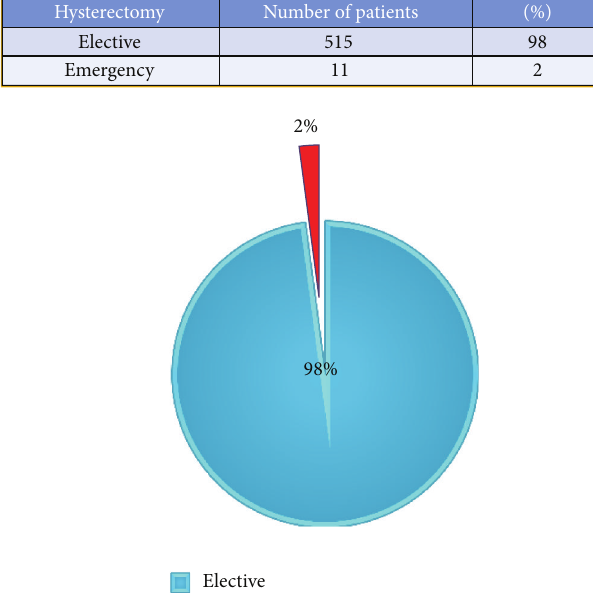
Figure 2: Elective versus emergency (including obstetric hysterec- tomies) hysterectomies.